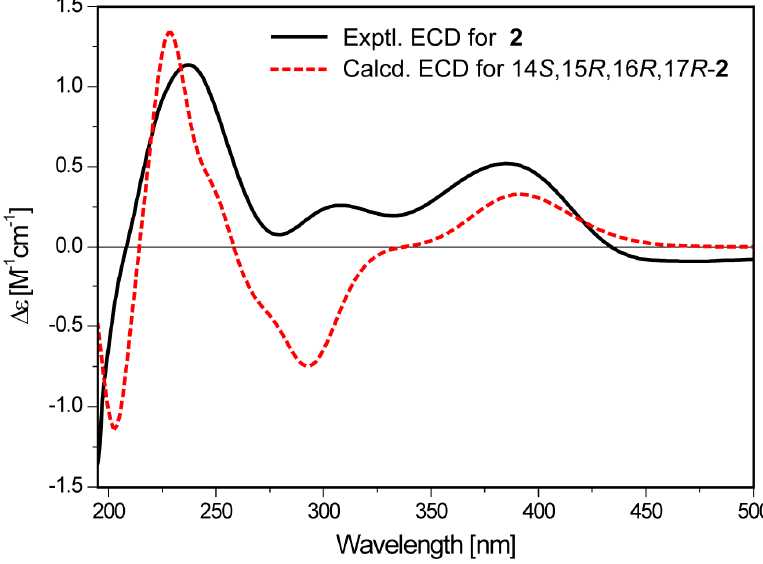
Figure 4. Comparison of the calculated and experimental ECD spectra of 2 .